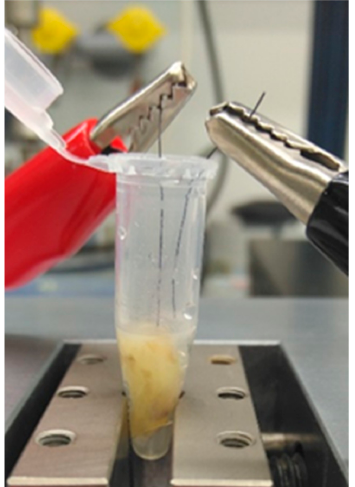
Figure 2. Experimental set-up for disinfection experiments using prototype 1 electrodes. The teeth were placed in 1.5 ml reaction tubes and phosphate-buffered saline (PBS) was added until the tooth was completely covered with liquid. The two separate electrodes were positioned inside the root canal and inside the tube,